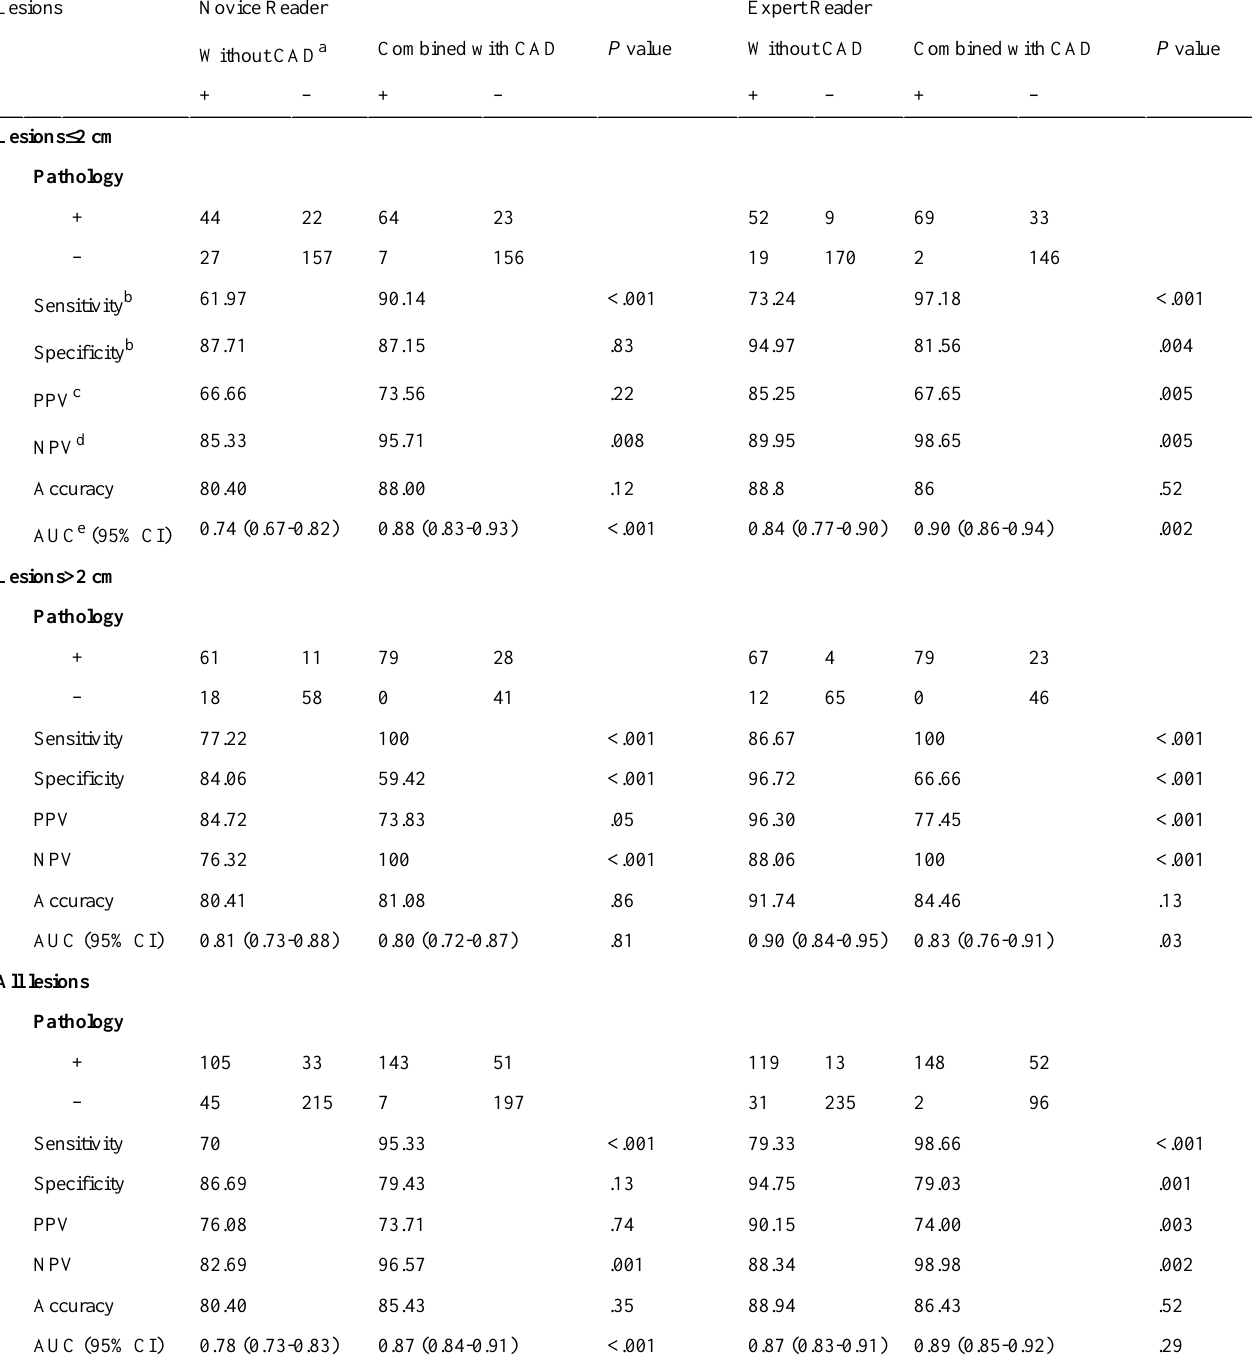
Expert ReaderNovice